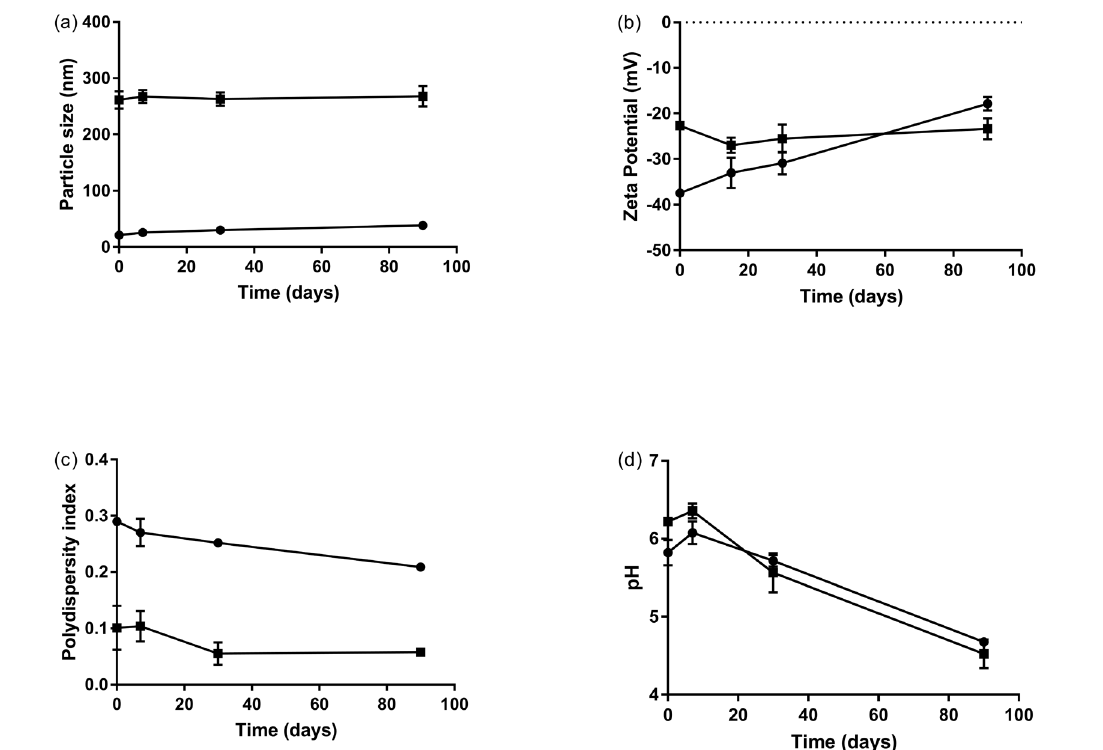
Figure 3. Stability study of the BC PC T80-NP ( potential (b), polydispersity index (c), and pH (d) of nanoparticles stored for 90 days at 4°C. Data are represented by mean ± standard deviation (n=